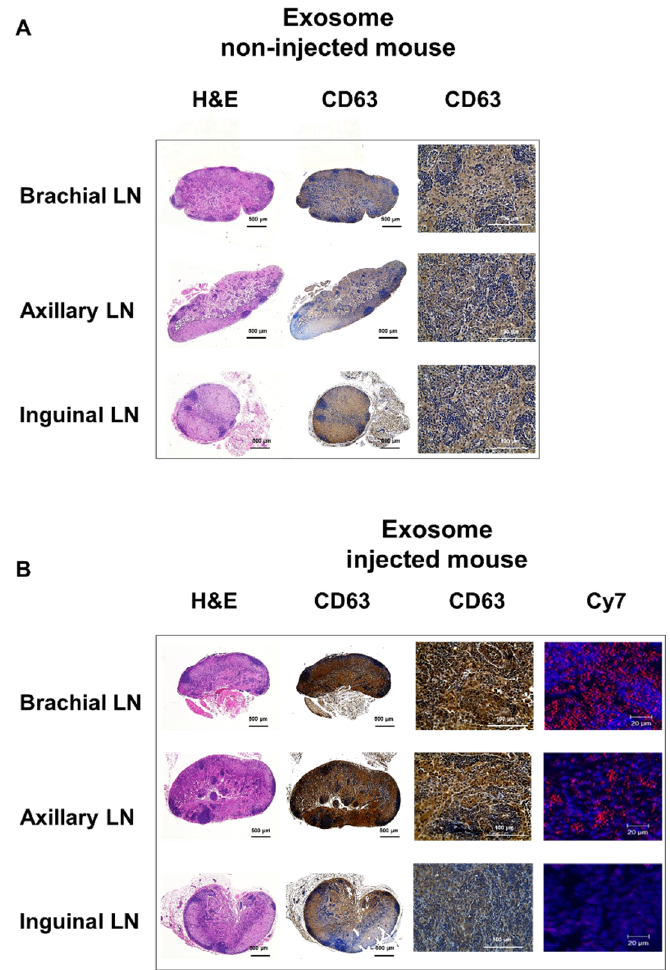
Figure 4. Ex vivo imaging of exosomes in the lymphatic route. The expression of CD63 (as an exosome marker) in the lymph node is higher in mice injected with exosomes ( A ) than in untreated mice ( B ), with higher uptake in the brachial and axillary lymph nodes than in the inguinal lymph nodes. Confocal microscope images show stronger Cy7 signals in the brachial and axillary lymph nodes. 2.4. In Vivo and Ex Vivo Imaging of Radiolabeled/Fluorescently Labeled Exosomes in the Hematogenous Route